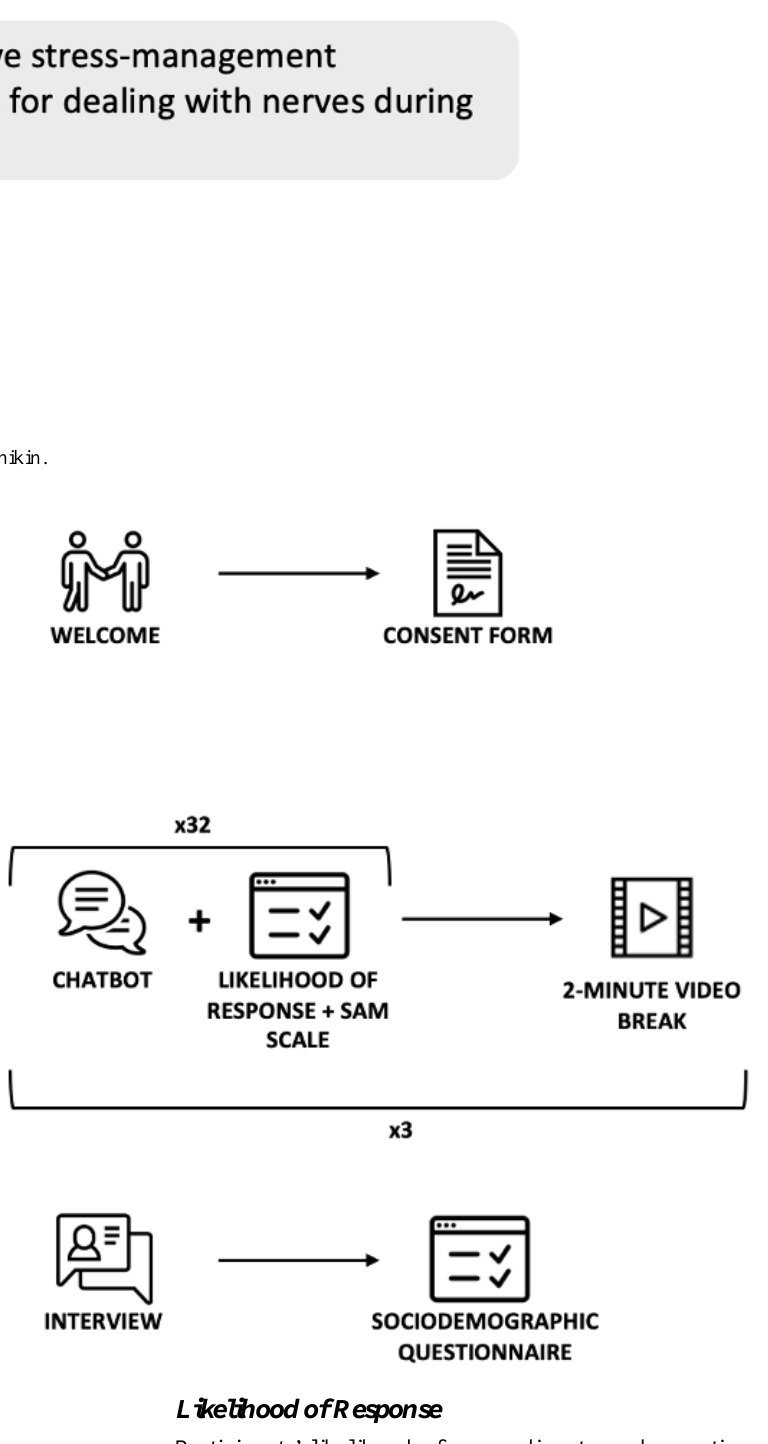
Figure 2. Sample question (professional tone, yes/no, without GIF).